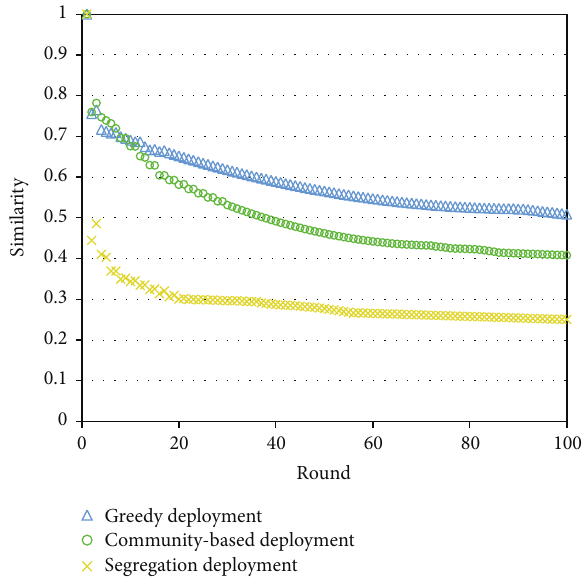
Figure 6: The similarity (average Kendall 𝜏 coefficient) between the initial preference matrix and the preference matrix after negotia-